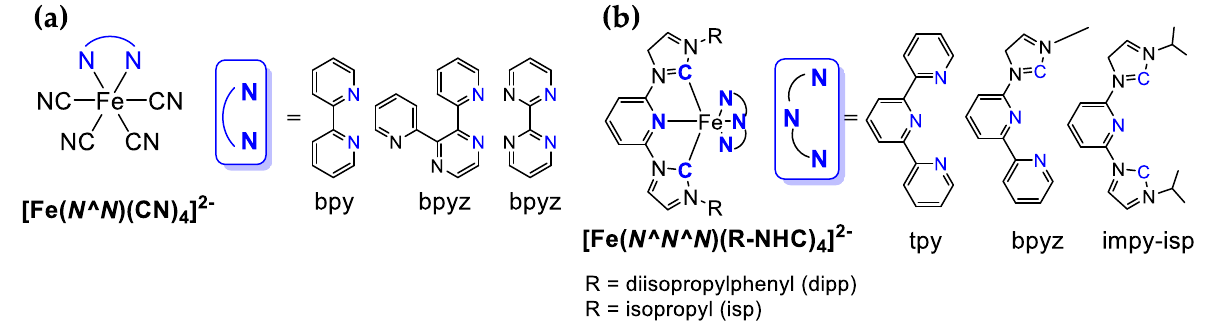
Figure 8. Chemical structures of the ( a ) [Fe(NˆN)(CN) 4 ] 2 − based and ( b ) [Fe(NˆNˆN)(R-NHC) 4 ] 2 − - based photosensitizers and corresponding ligands in this review.